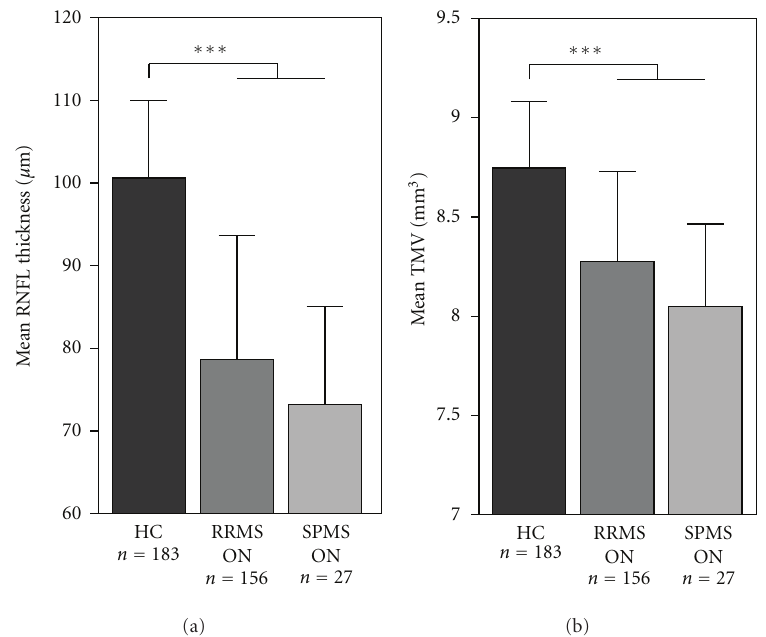
Figure 2: Mean retinal nerve fibre layer (RNFL) thickness (a) and mean total macular volume (TMV) (b) for the healthy controls (HC) and MS subtypes (RRMS, SPMS) with a history of optic neuritis (ON). Significant di ff erences between the groups are indicated with ∗ ( P < 0 . 05), ∗∗ ( P < 0 . 01), and ∗∗∗ ( P < 0 . 001),